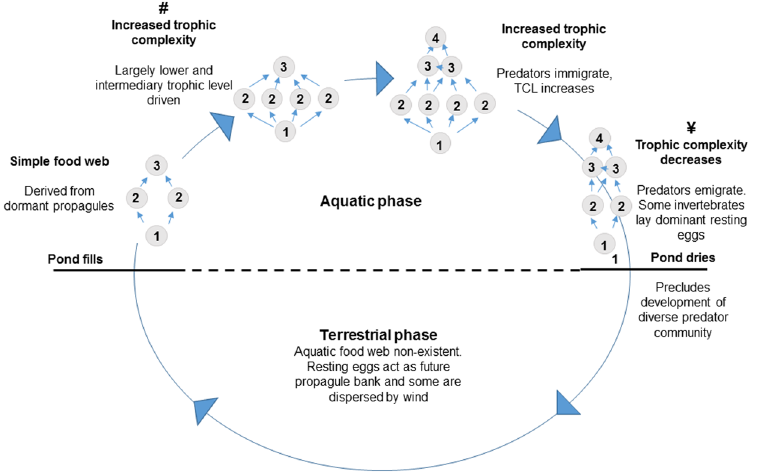
Figure 3. Proposed conceptual model of temporal food web changes outlining ( # ) intermediate trophic level widening due to increased richness, herbivory and/or omnivory, and ( ¥ ) mechanism reducing relative predator diversity increases. The model shows widening of the carbon range and elongation of the trophic structure with time before it becomes simple again. TCL = trophic change